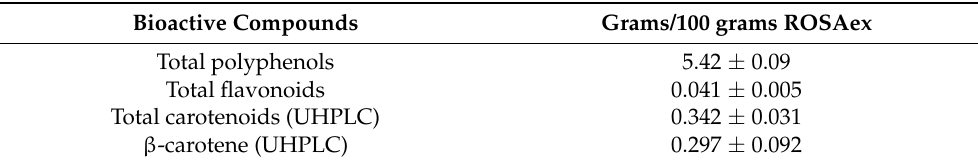
Table 3. The content of total polyphenols, total flavonoids, β -carotene and total carotenoids in freeze-dried ROSAex (grams/100